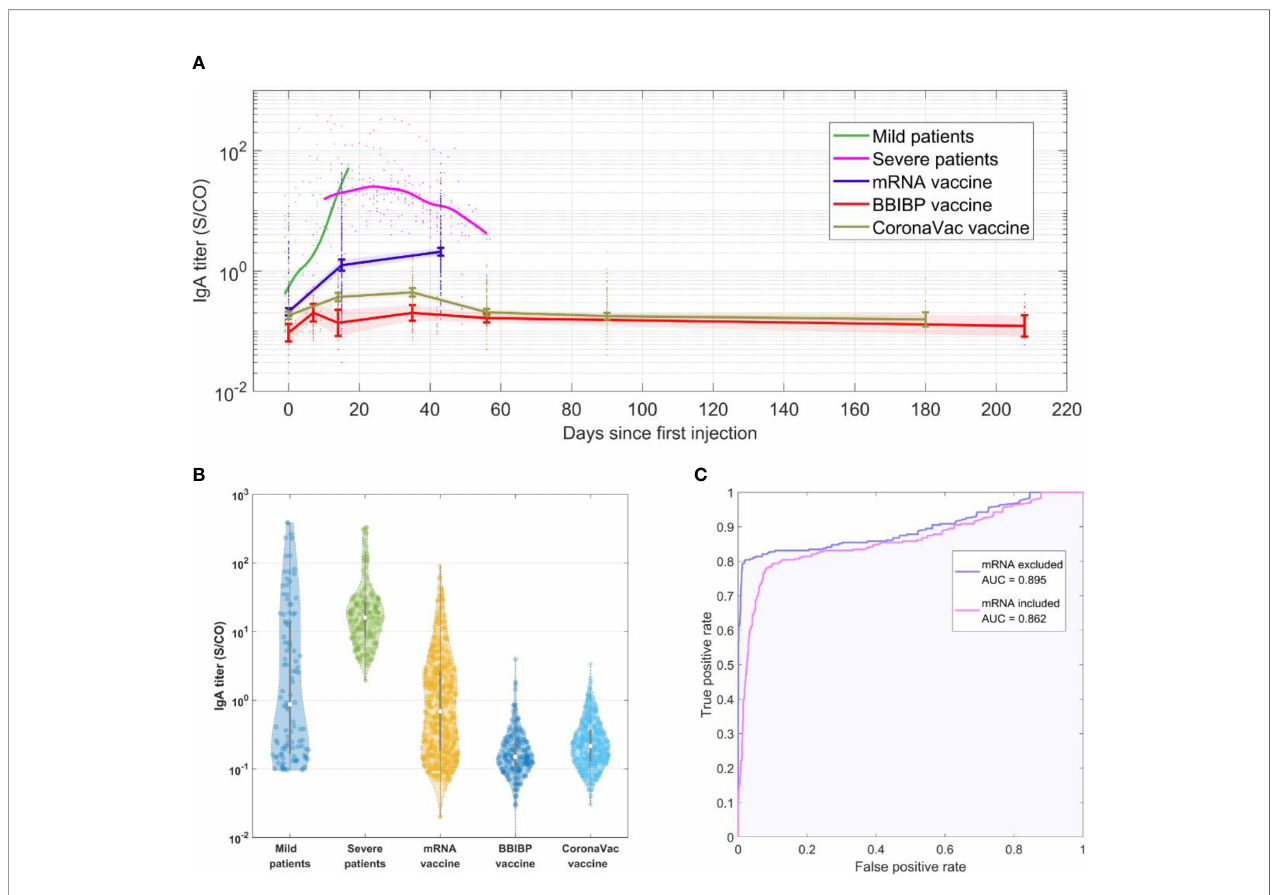
FIGURE 1 | (A) SARS-CoV-2-IgA titer in each cohort over time. (B) Violin plot showing distribution of SARS-CoV-2-IgA titer levels in each cohort. The samples at different time points for each cohort were collected as a whole group. The gray lines in the center of each violin show the median, and the 25 th and 75 th percentiles. (C) ROC curve showing performance of diagnosing COVID-19 infection using SARS-CoV-2-IgA titer